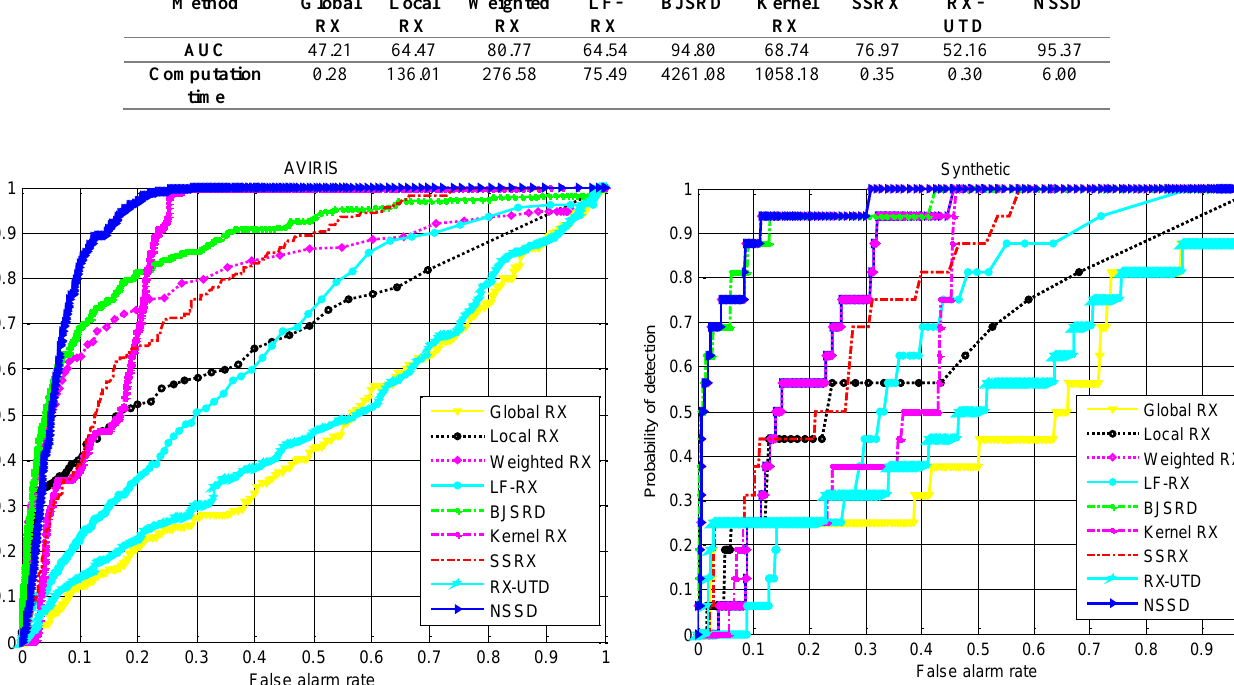
Figure 3. ROC curves for NSSD and other anomaly detectors for real AVIRIS image and the synthetic dataset. The ROC curve of each method that is nearer to the top left corner illustrates a more detection